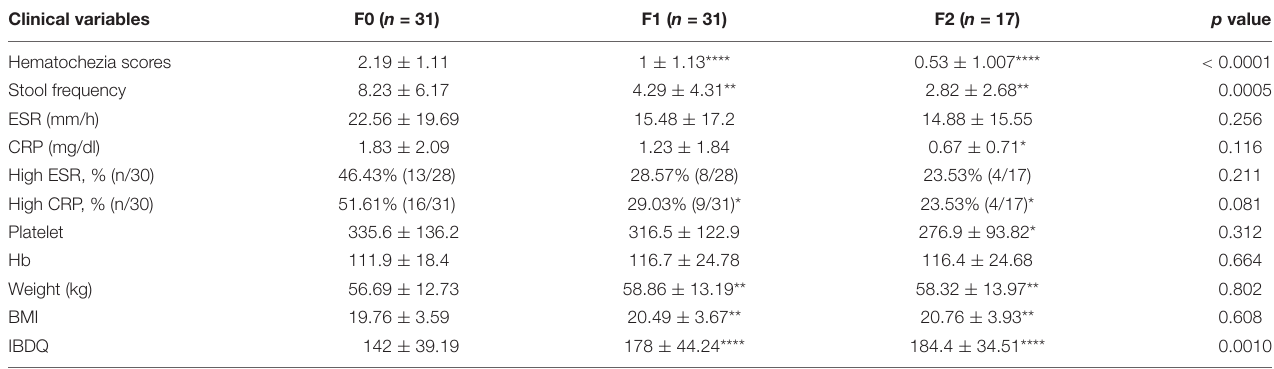
TABLE 3 | Clinical variables before and after FMT.